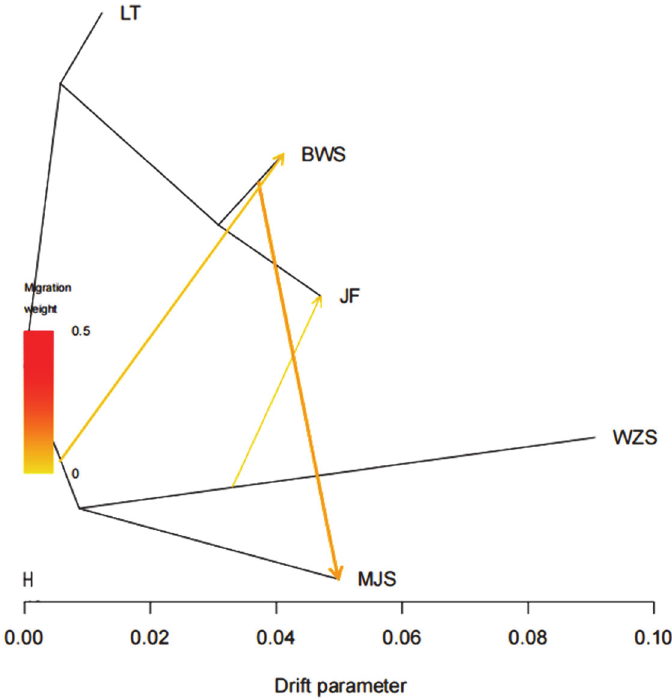
Figure 5. Maximum-likelihood tree and gene flow among P. bungeana populations inferred using TreeMix. Arrows indicate the direction of gene flow, while the line colors and thickness represent the migration weight based on sample number. Each branch represents a population, and the length of the horizontal branch refers to the proportion of genetic drift that occurs on each branch. The abscissa axis represents the genetic drift parameters.